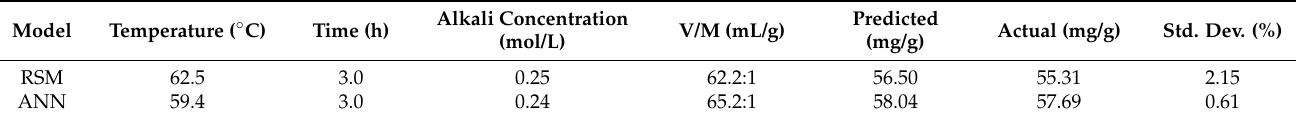
Table 5. Comparison and verification of different models to extract SEP.